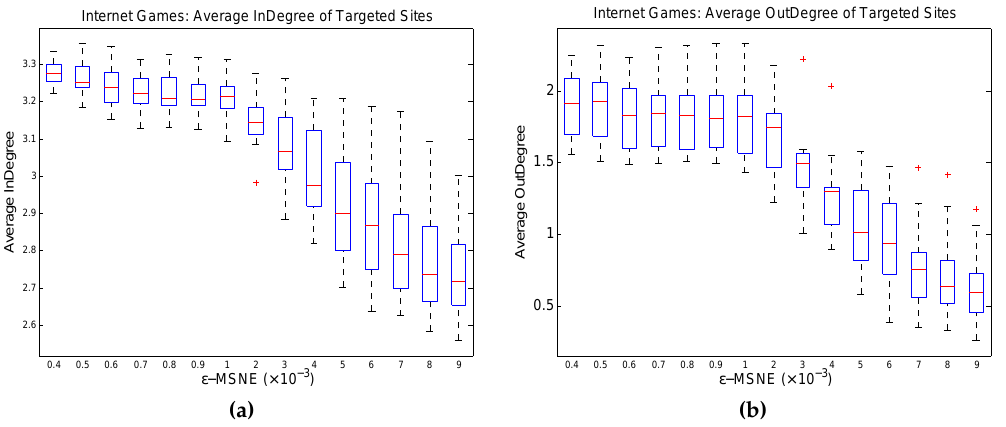
Figure 15. Degrees of the Targeted Site Nodes at (cid:101) -MSNE. Internet Games: average indegree ( a ) and average outdegree ( b ) of the targeted sites over (cid:101)